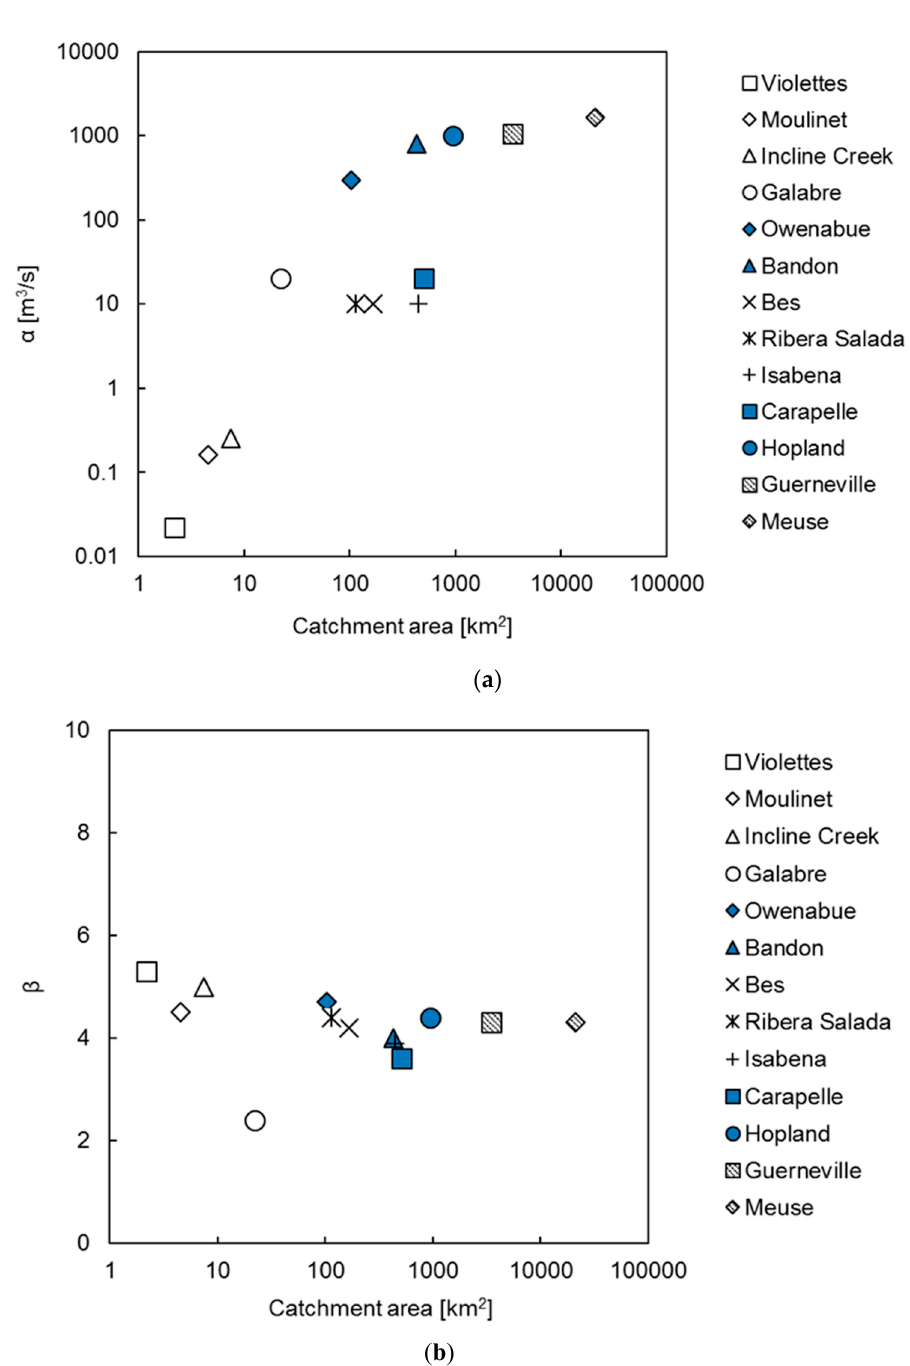
Figure 6. Model parameter dependency on the catchment area. ( a ) the relationship between α and the catchment area and ( b ) the relationship between β and the catchment area.